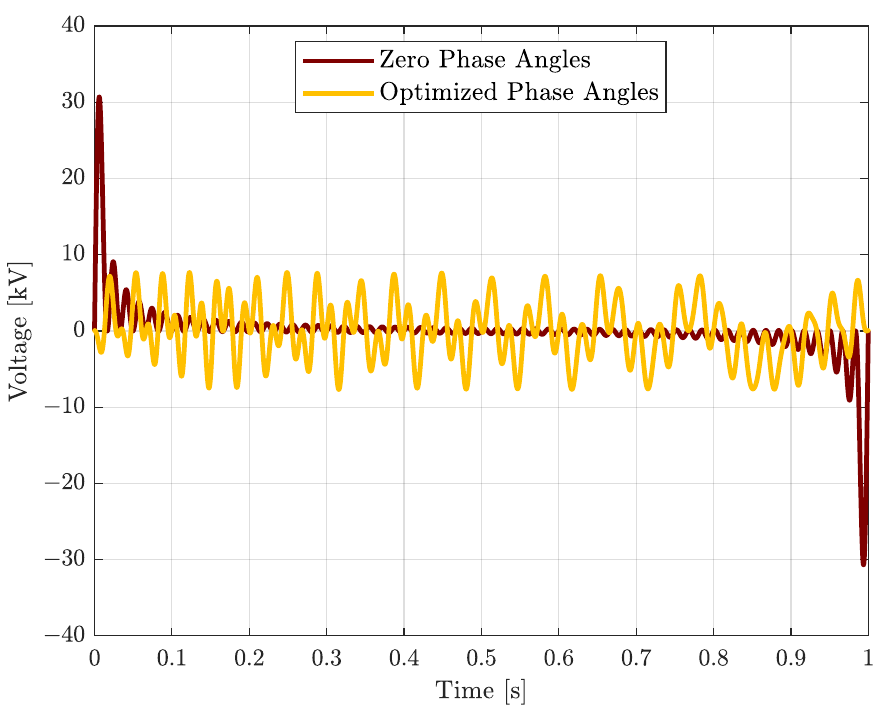
Figure 5. Multifrequency injection signal from 1 Hz to 60 Hz with zero phase angles (red), and optimized phases (yellow).